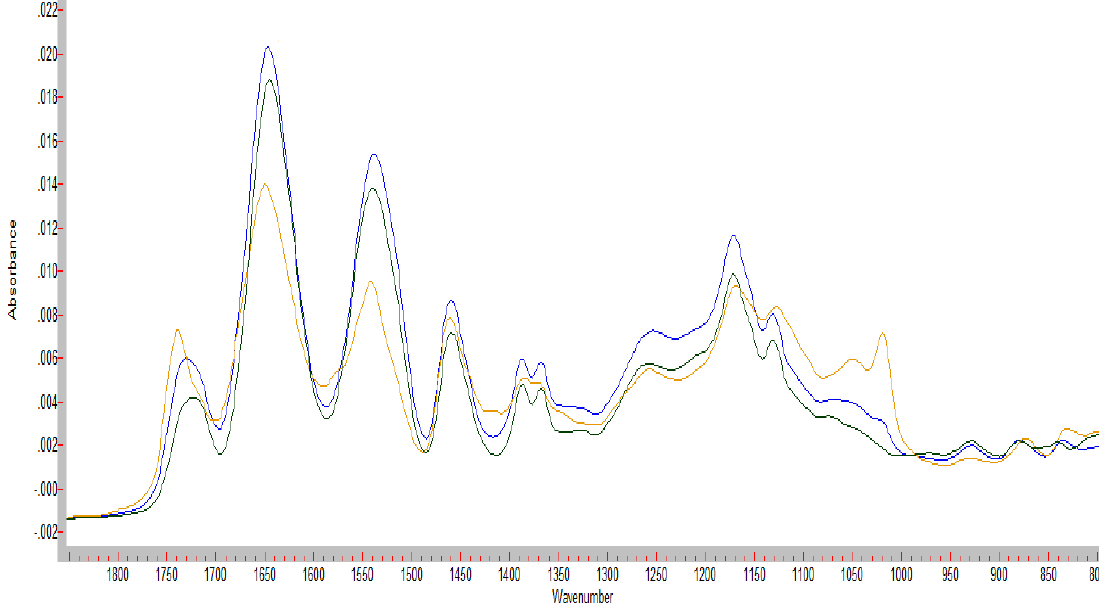
Figure 9. FT-IR spectra of the hydrogel NIP-AVa-PEG258 (blue line), NIP-AVa-PEG258 with cisPt (yellow line), and NIP-AVa-PEG258 with cisPt and NPs (green